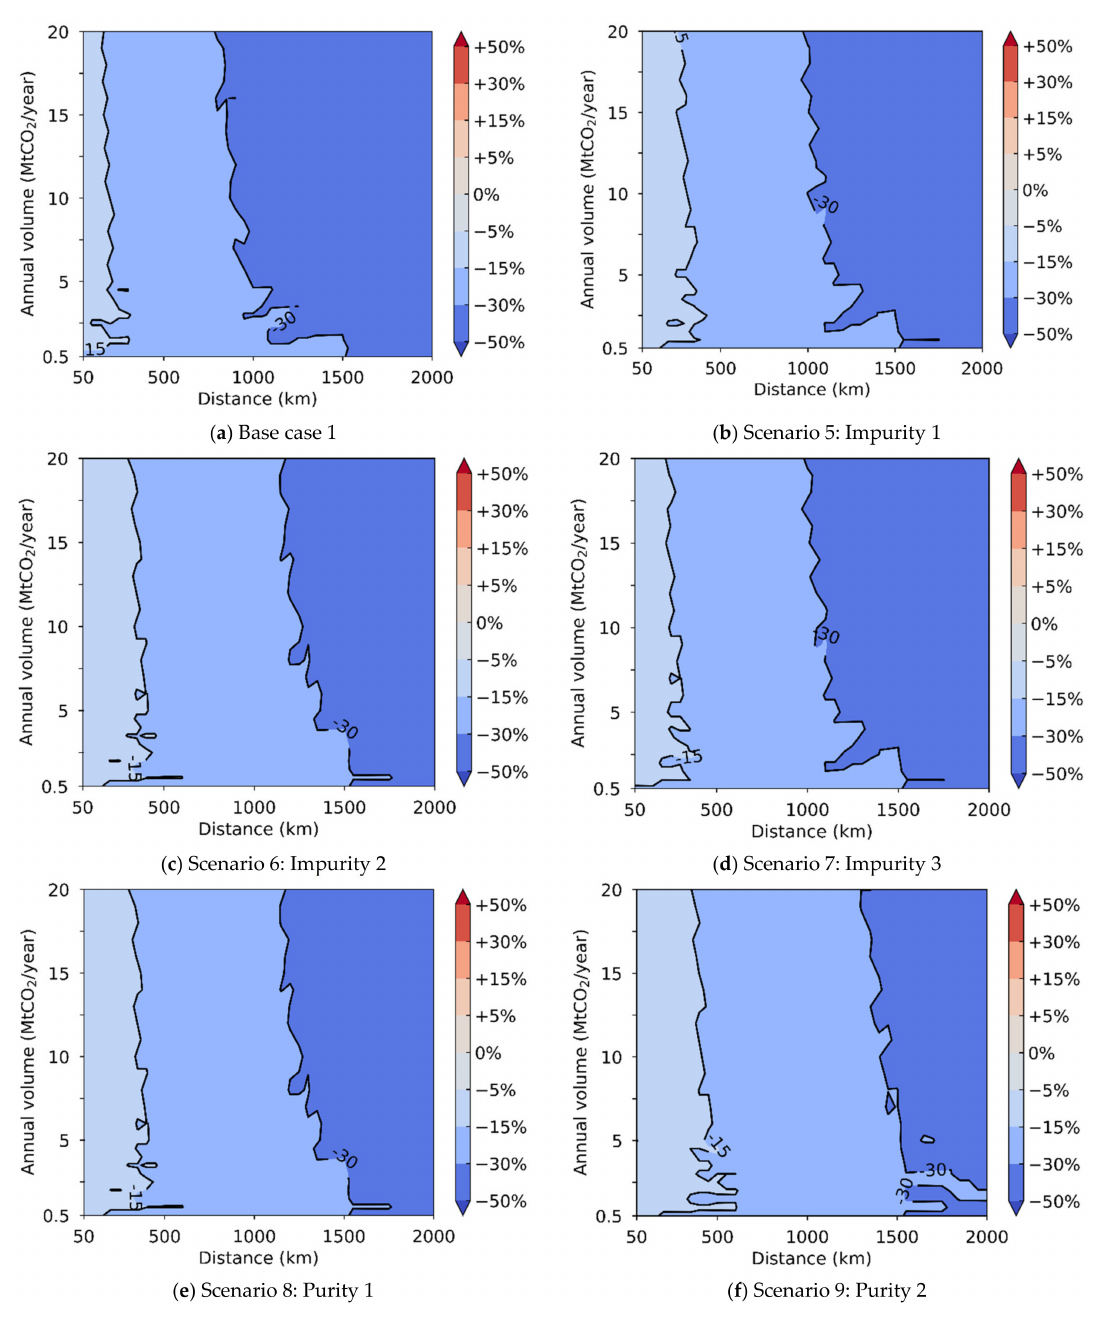
Figure 8. Cost comparison maps showing relative cost reductions (%) enabled by the 7 barg option compared to the 15 barg one in the case of ship transport between two harbours under a variety of impurity and purity constraint